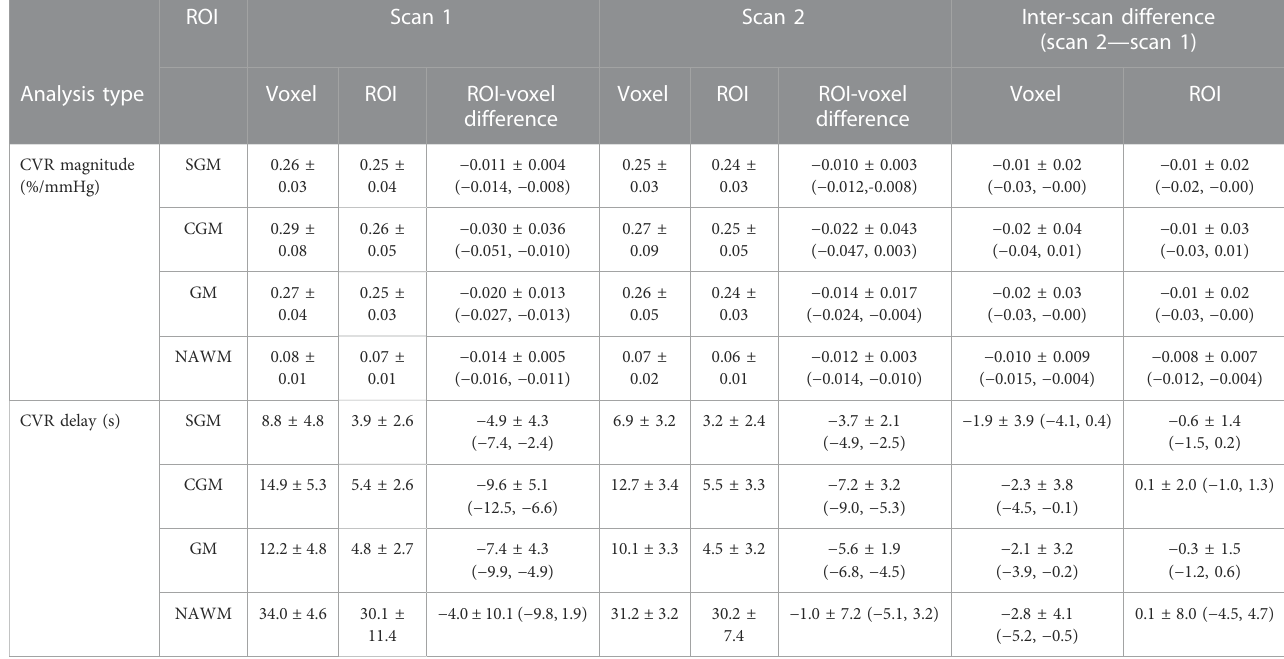
TABLE 1 Mean and standard deviation across subjects of CVR magnitudes and delays in SGM, CGM, GM and NAWM computed for each scan with ROI- and voxel-based processing. Mean ± standard deviation of the inter-scan and inter-analysis differences are reported with the 95% con fi dence intervals in parentheses. ROI Scan 1 Scan 2